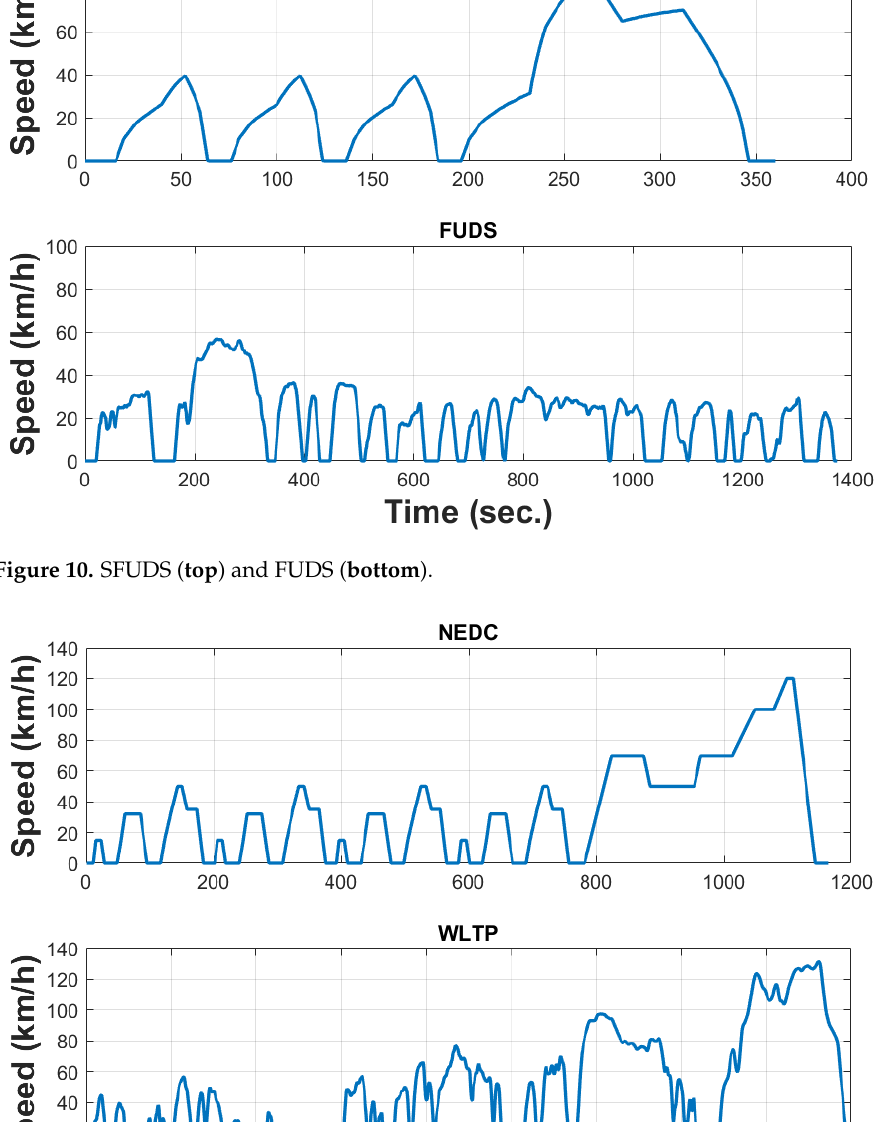
Figure 12. Electric power required by SFUDS (top) and FUDS (bottom).